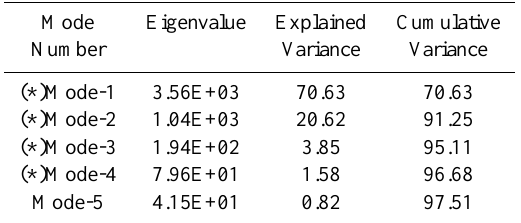
Table 3. Eigenvalues associated with the first 5 EOF modes, the fraction of variance retained by each mode and the cumulative vari- ance. An asterisk denotes the statistically significant EOF